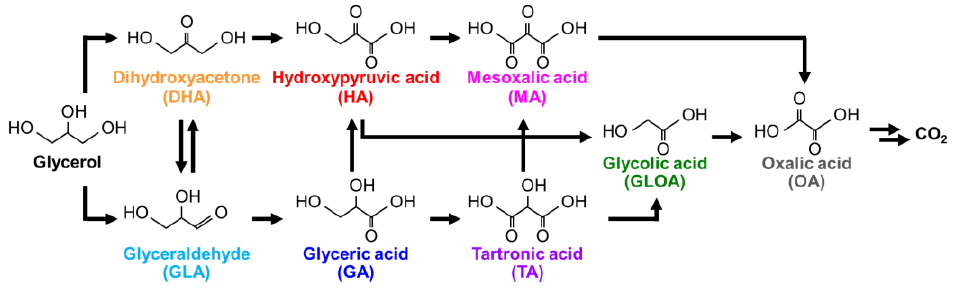
Figure 1. Proposed routes of glycerol oxidation.